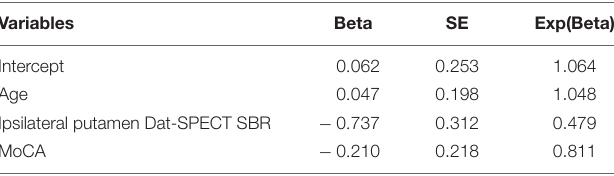
TABLE 3 | Clinically selected model 2 to predict motor progression in individuals with PD.